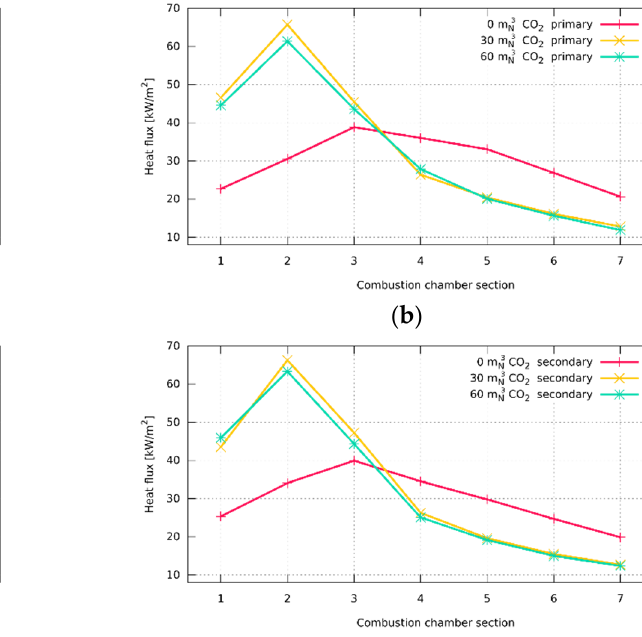
Figure 11. Influence of inert gas addition on heat flux distribution—burner with staged fuel distri- bution—Burner A: ( a ) primary regime; ( b ) secondary regime.